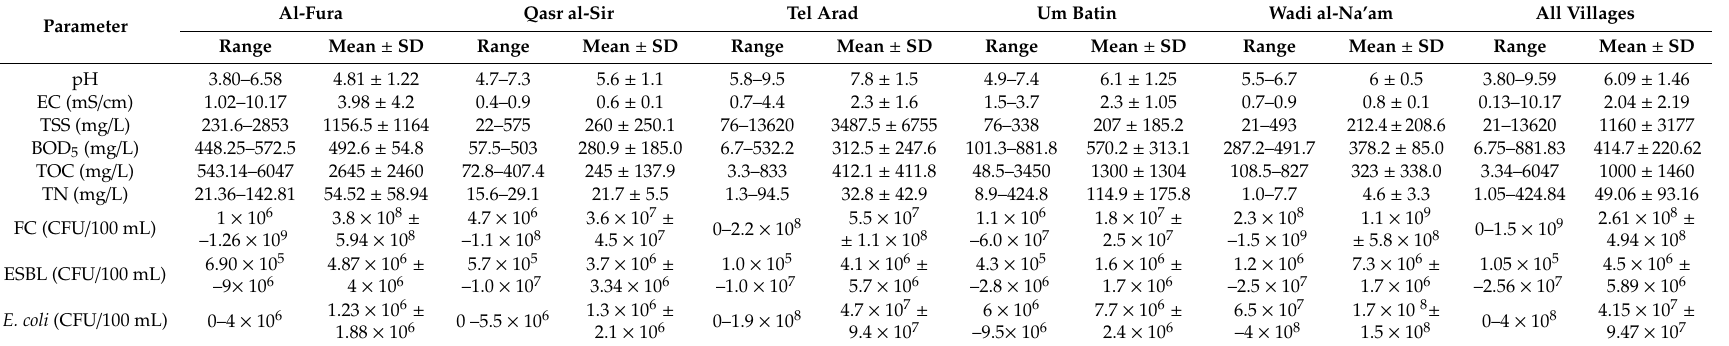
Table 1. Physiochemical parameters of untreated household greywater (GW) samples collected from Bedouin villages.